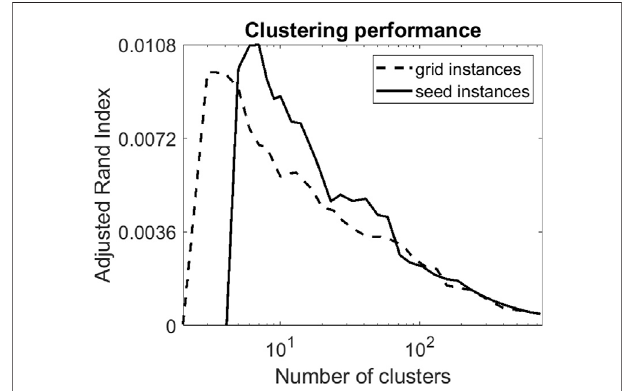
FIGURE 5 | The two cluster analyzes evaluated by the Adjusted Rand Index. The interval (0, 1) runs from no relation with labeling to a complete consistency.Theseedinstancesareslightlybetterrelatedwiththeslidelabels, but still almost random. Gates and Ahn (2017) for a study on evaluating clustering performances.